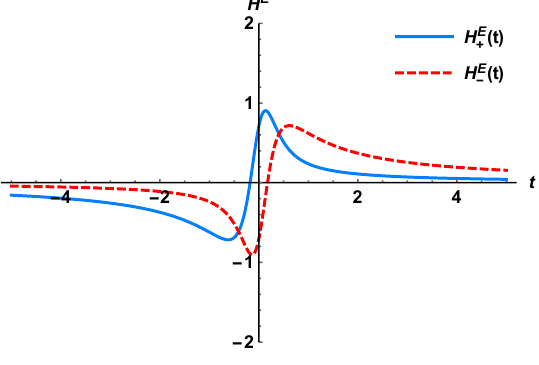
Figure 4 . Hubble parameters in the Einstein